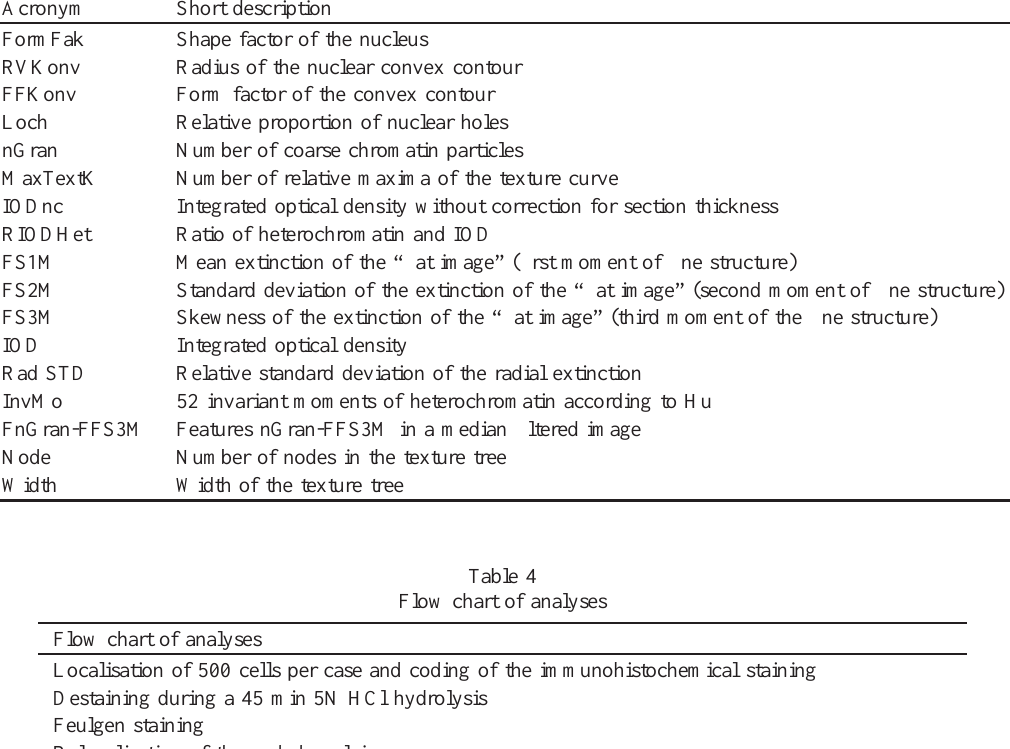
Table 3 Selection of the cytometric features (with statistical relevance in this study)